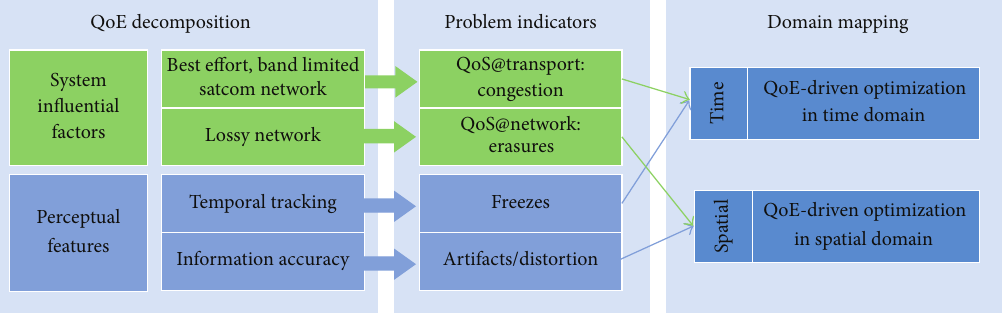
Figure 1: Scenario-specific QoE framework with decoupling in time and space domains of